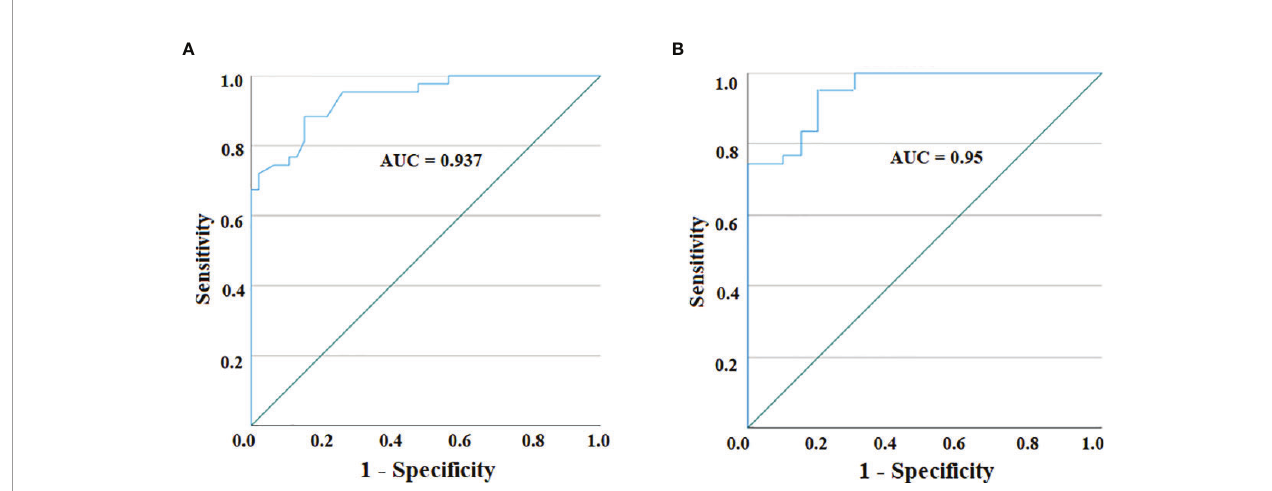
FIGURE 2 | ROC curve for IL-19 serum levels in PA patients vs . HC (A) and between PA patients and IDA ones (B) . The AUC for both curves reveal a highly accurate test performance (0.9 ≤ AUC < 1).